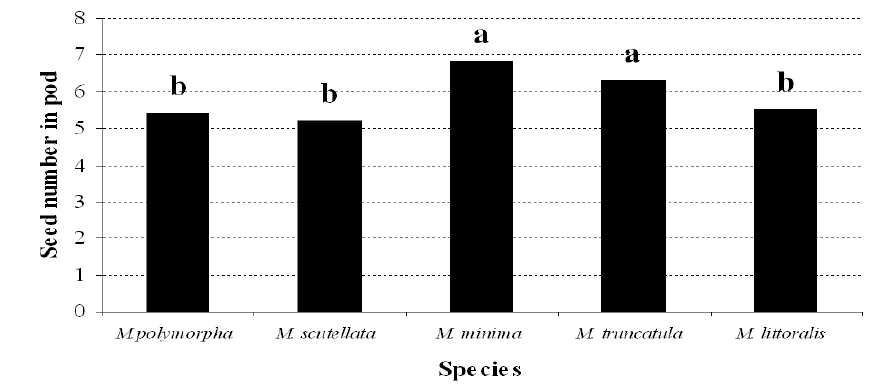
Fig. 11. Main effects of species on seed number in pod. All the values followed by the same letter in each column are not statistically different at the p<0.05 probability